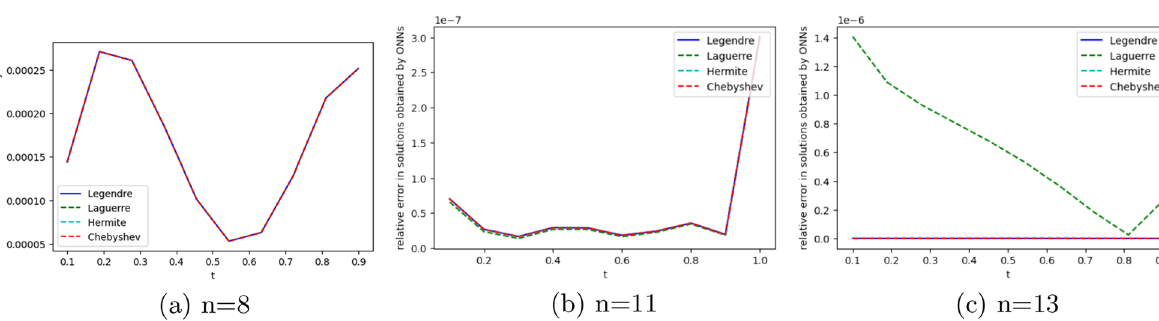
Figure 9. Error graph for different orthogonal neural networks with different numbers of neurons for Example